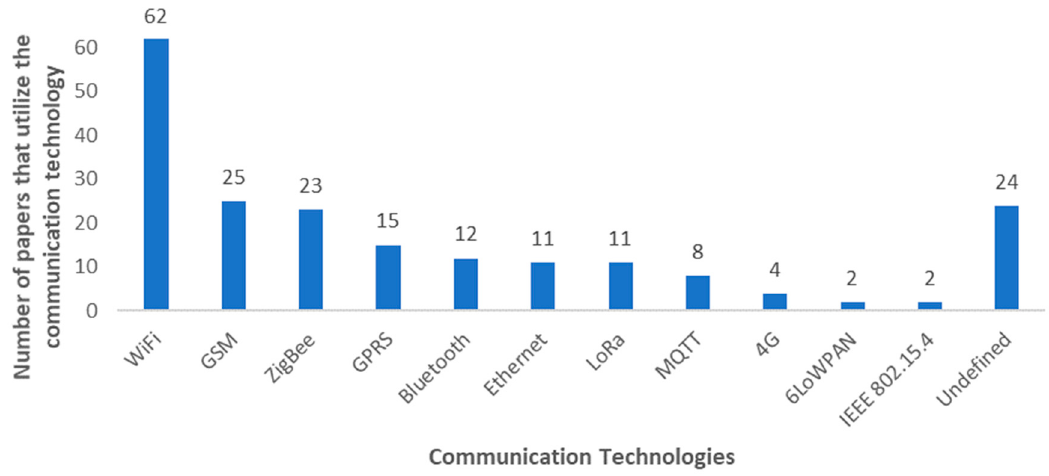
Figure 25. Communication technologies employed to implement IoT irrigation systems.